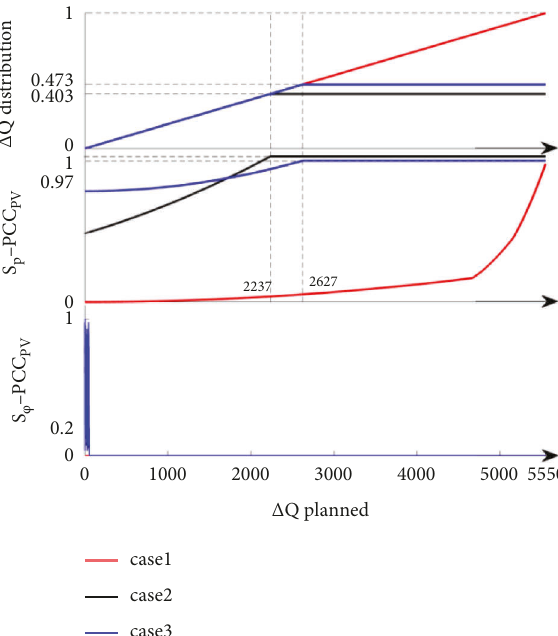
Figure 8: The results of algorithm 3 for the